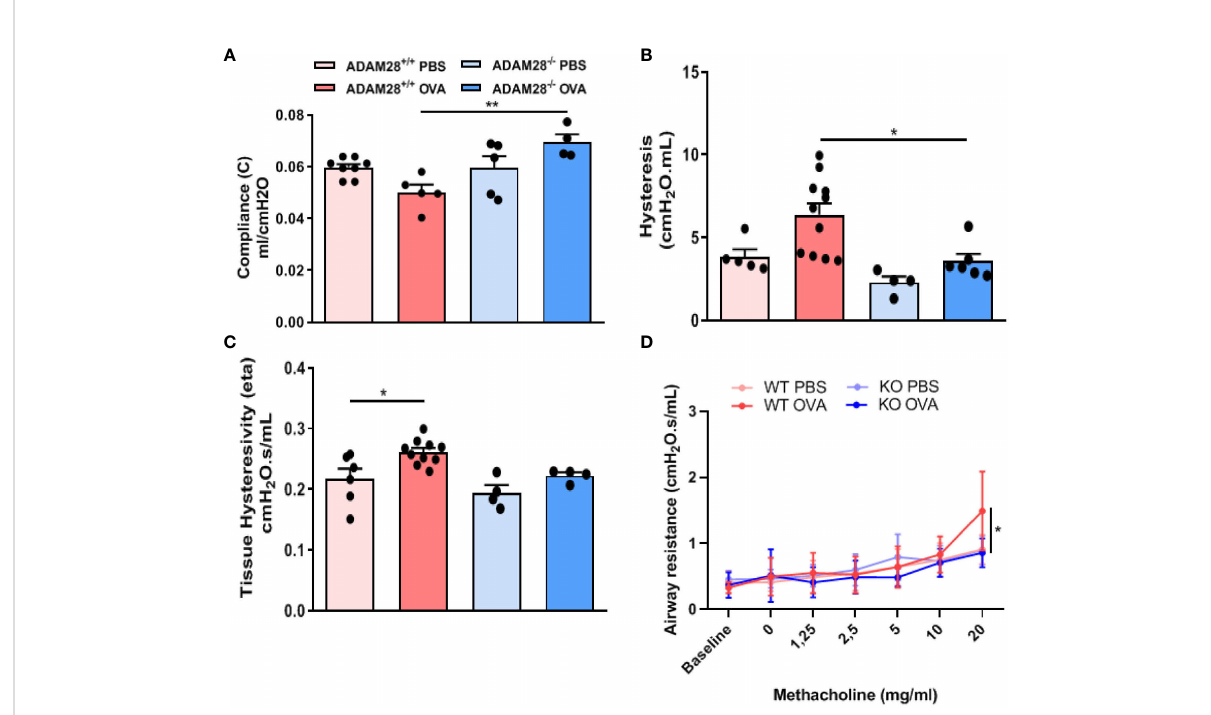
FIGURE 4 Measurement of airway function in ADAM28 -/- and ADAM28 +/+ animals after allergen (OVA) or sham exposure (PBS). (A) Baseline lung compliance (N=2; ADAM28 +/+ - PBS n=8, ADAM28 +/+ - OVA n=5, ADAM28 -/ – PBS n=5, ADAM28 -/ – OVA n=4), (B) lung hysteresis (N=2; ADAM28 +/+ - PBS n=5, ADAM28 +/+ - OVA n=11, ADAM28 -/ – PBS n=4, ADAM28 -/ – OVA n=6) (C) lung hysteresivity (N=2; ADAM28 +/+ - PBS n=6, ADAM28 +/+ - OVA n=10, ADAM28 -/ – PBS n=4, ADAM28 -/ – OVA n=4). (D) Measurement of the airway responsiveness. The airway resistance was measured via the forced oscillation technique (Flexivent ® ) 24h after the last OVA or PBS exposure after exposure to increasing concentrations of methacholine. Results are expressed as mean ± SE, (N=2; ADAM28 +/+ - PBS n=7, ADAM28 +/+ - OVA n=10, ADAM28 -/ – PBS n=3, ADAM28 -/ – OVA n=6). *p<0.05, **p<0.01 (One way